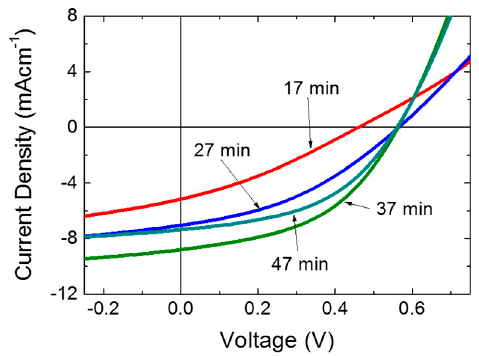
Figure 3. J ‐ V curve ITO/CdS/P3HT:PCBM blend/PEDOT:PSS/MoO 3 /Ag devices with different CdS Figure 3. J-V curve ITO/CdS/P3HT:PCBM blend/PEDOT:PSS/MoO 3 /Ag devices with different CdS deposition times. deposition times.